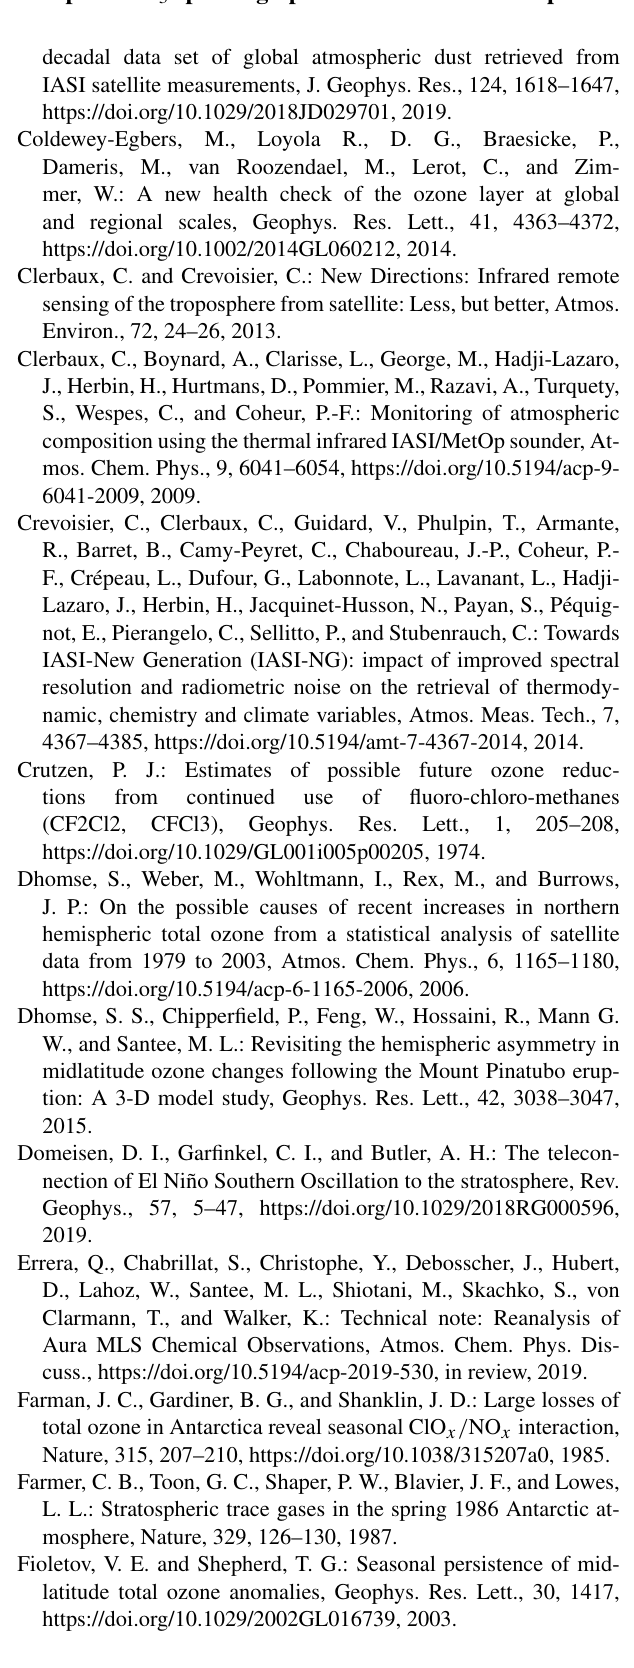
Brasseur, G.: The response of the middle atmosphere to long-term and short-term solar variability: A two-dimensional model,